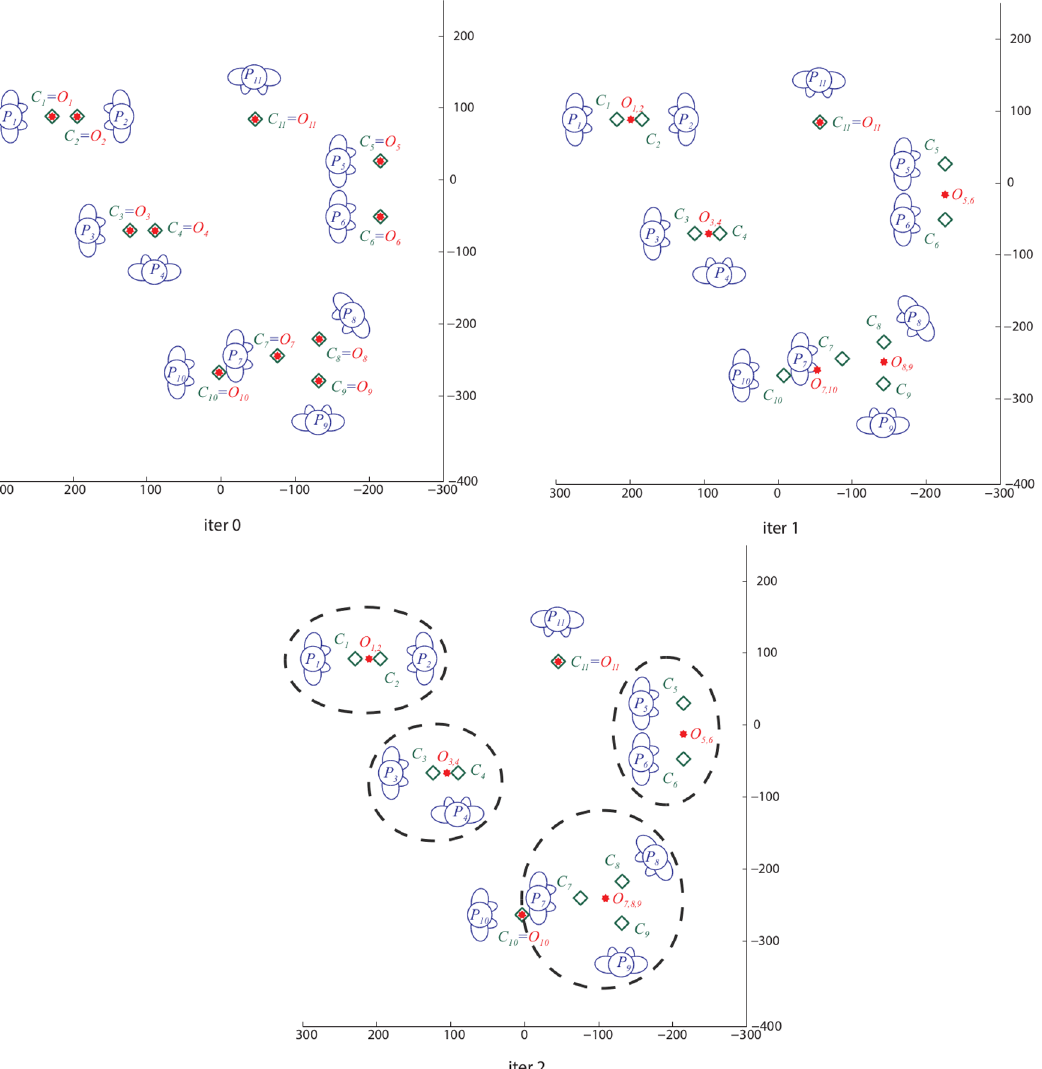
Fig 6. An explicative example. Iteration 0: initialization with the candidate o-space centres { O } coincident with the transitional segment of each individual { C }. Iteration 1: first graph-cuts run; easy groups are correctly clustered while the most complex still present errors (the FCG formed by P 7 and P 20 violates the visibility constraint). Iteration 2: the second graph-cuts run correctly detects the O 7,8,9 F-formation (at the bottom). Se text for more details.